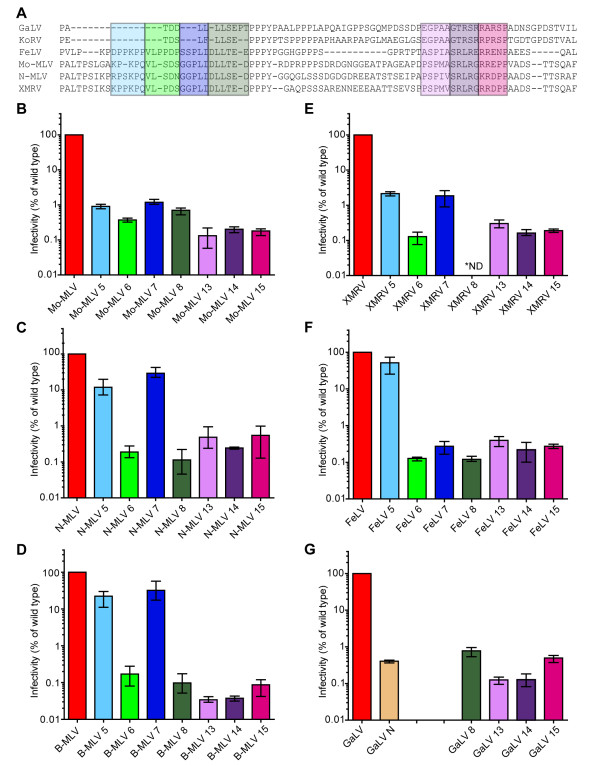
The effects of p12 mutations in different gammaretroviruses. (A) An alignment of the p12 sequence from various gammaretroviruses is shown. Shaded boxes indicate the position of each p12 mutant in each species and colours correspond to the bar colours in the graphs below. As GaLV has a small N- terminal region, the mutant TDDLL/AAAAA has been named GaLV N (G). (B-G) LacZ-encoding wild type or mutant VLPs were produced for each species of gammaretrovirus and equivalent RT-units of VLPs were used to challenge D17 cells. Infectivity was measured by detection of β–galactosidase activity in a chemiluminescent reporter assay. Results are plotted as the percentage of infectivity compared to the infectivity of the corresponding wild type VLPs for each species. The mean and range of three independent experiments are shown.